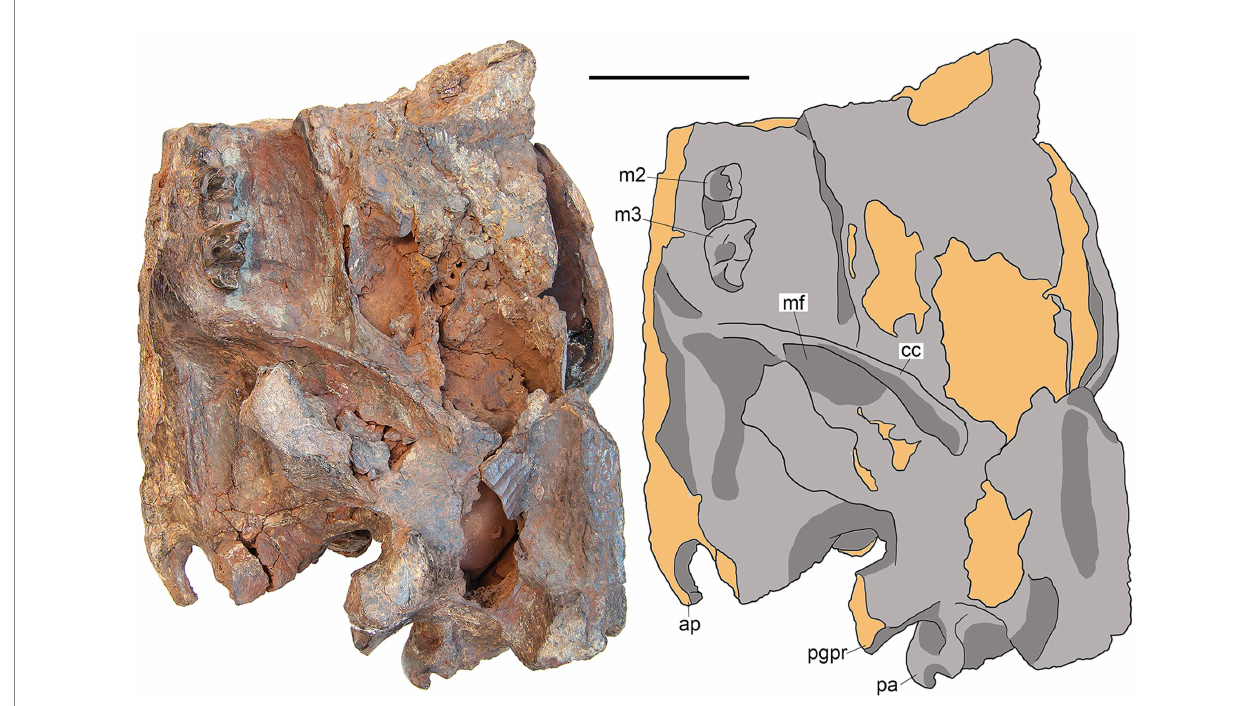
FIGURE 4 M. peregrinus , gen. et sp. nov., SYSU-M-5, holotype, a partial skull with associated mandibles in left lateral view (photograph and explanatory drawing). Youganwo Formation, upper Eocene, Maoming locality, Guangdong Province, China. ap, angular process; cc, coronoid crest; mf, masseteric fossa; pa, paroccipital apophysis; pgpr, postglenoid process. Scale bar equals 5 cm.